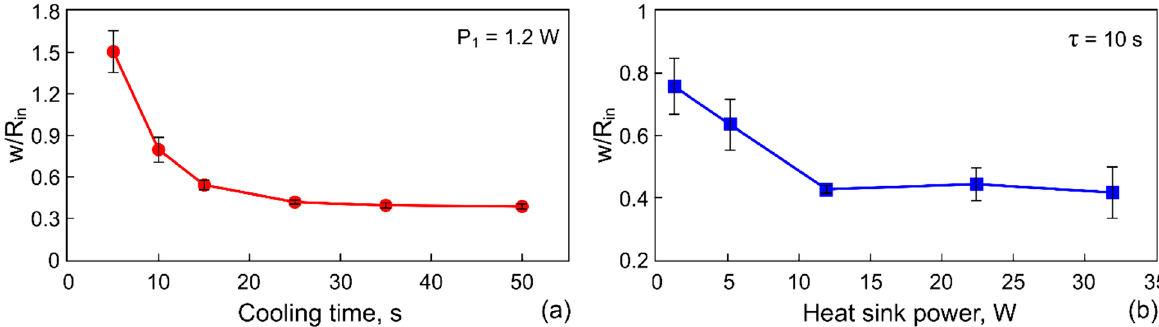
Figure 8. The ratio of the width of the ring to the radius of its inners area versus the cooling time spans at 𝑃 = 1.2 W ( a ) and the cooling power of Peltier module at 𝜏 = 10 s ( b ).